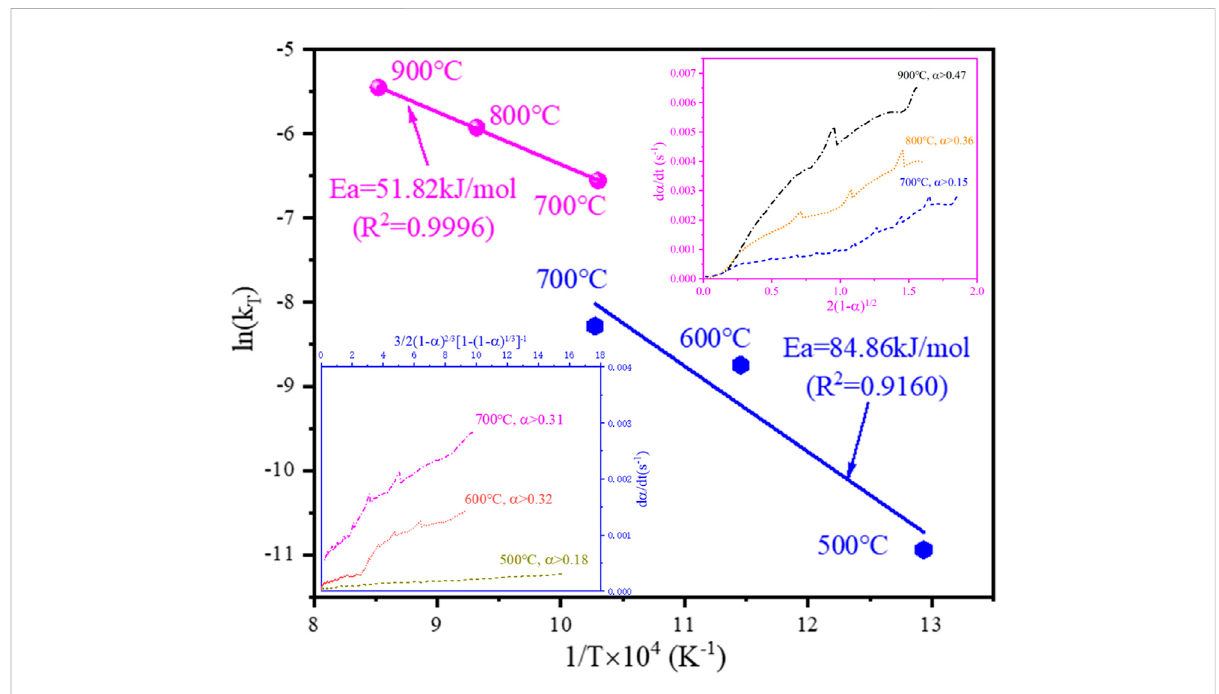
FIGURE 10 The Arrhenius plot for the isothermal reduction tests from 500 ° C to 900 ° C and the linear relationship between the rate of reaction and the differential form of the 3D diffusion model and R2 contracting area